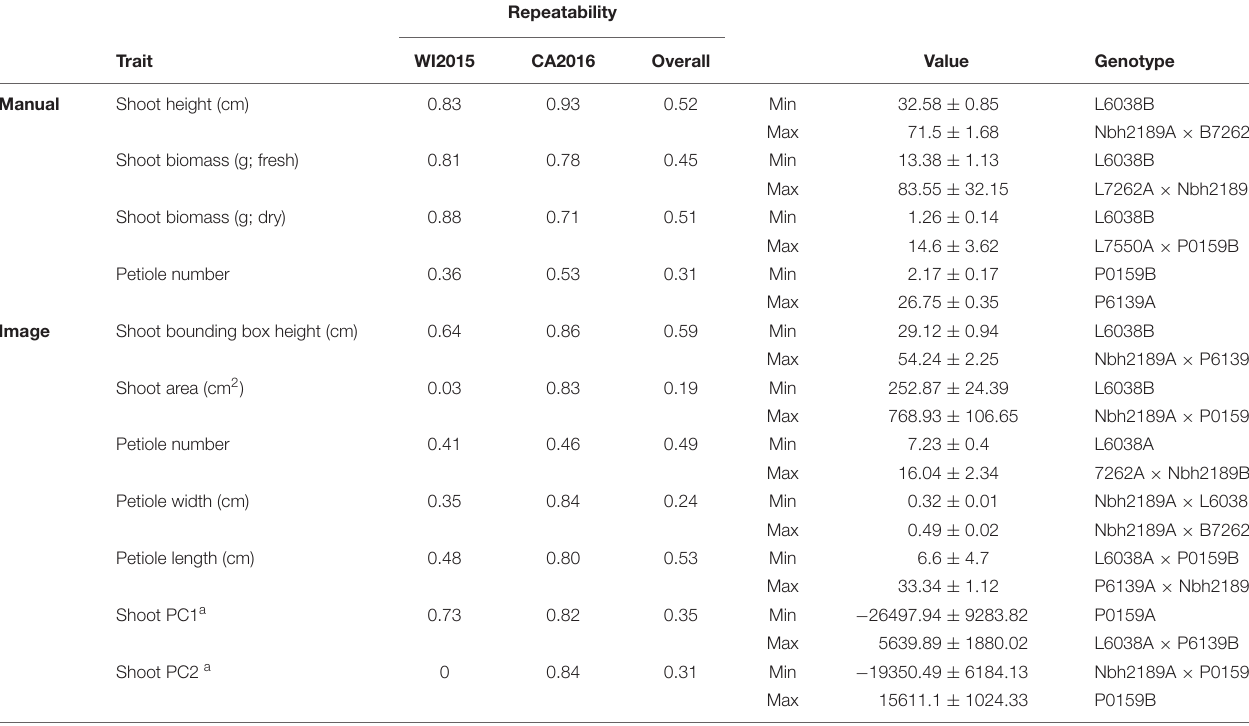
TABLE 1 | Estimates of repeatability, trait ranges, and corresponding pedigrees for shoot characteristics in 42 inbreds and hybrids from a six-parent carrot diallel.